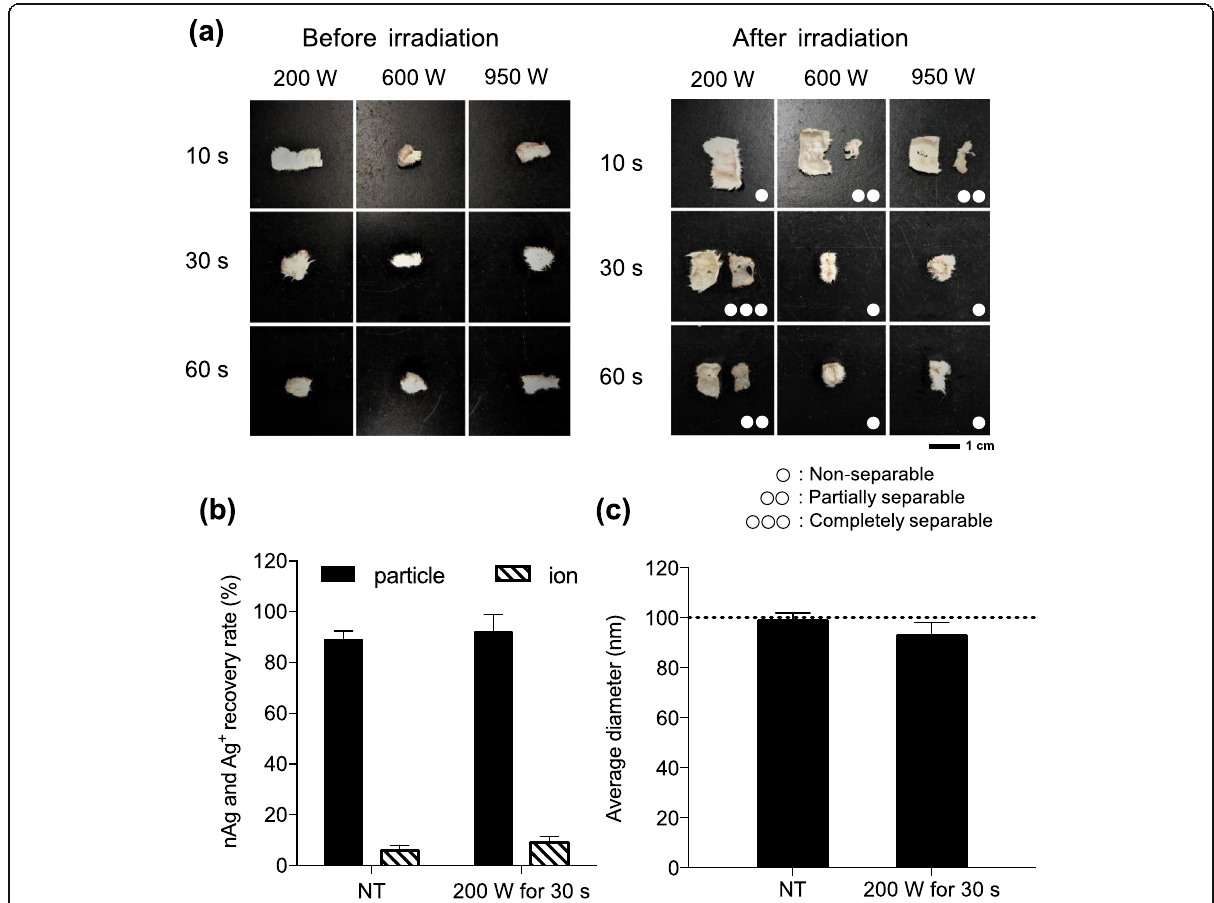
Fig. 3 Screening and evaluation of conditions for separating the skin into epidermis and dermis by microwave irradiation. a Skin tissue was irradiated with microwaves under nine conditions and separated into epidermal and dermal tissues. Left and right panels show skin samples before and after irradiation, respectively. In the right panel, single, double, and triple white circles show non-separable, partially separable, and completely separable conditions, respectively. Scale bars: 1 cm. Skin homogenates were mixed with nAg100 to obtain a final Ag concentration of 100 ng/mL, and irradiated at 200 W for 30 s, and analyzed via sp-ICP-MS. b The nAg (black bars) and Ag + (shaded bars) recovery rates and c average particle diameters are presented. The dashed line represents the initial particle size. The data have been expressed as mean ± S.D. ( n =